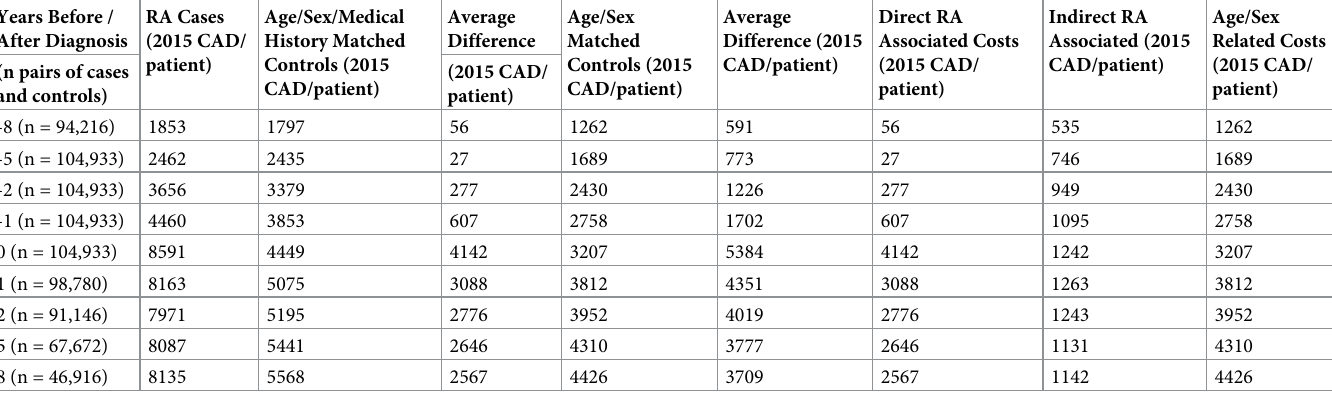
Table 2. Total patient outcomes at year of diagnosis and 1, 2, 5, and 8-Year pre-and post-diagnosis (Data source for Fig 3). Years Before / RA Cases After Diagnosis (2015 CAD/